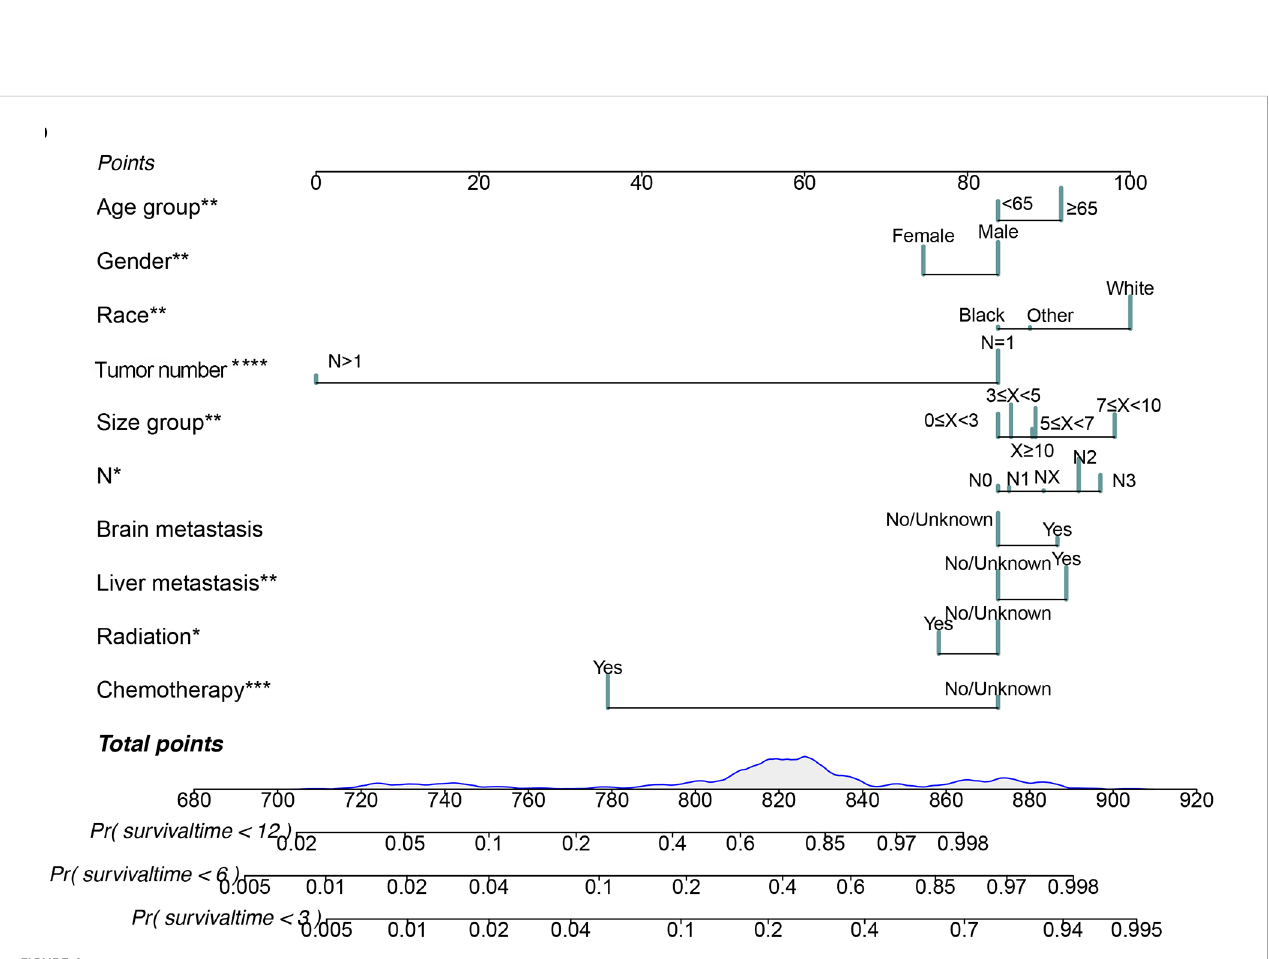
FIGURE 4 Nomogram for predicting 3-month, 6-month and 12-month cancer-speci fi c survival in SCLC patients with BM. *P < 0.05, **P < 0.01, ***P < 0.001.